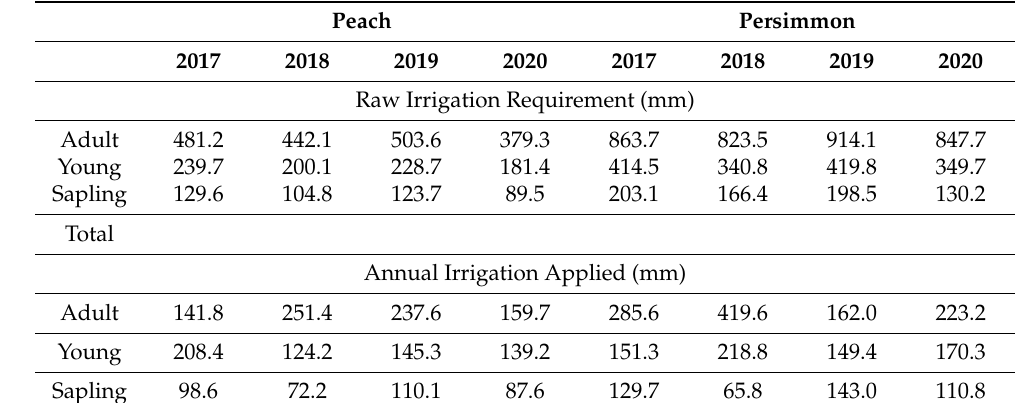
Table 5. Calculated raw irrigation requirements and averages of the annual irrigation depths applied to the different plots for persimmon and peach orchards for years 2017, 2018, 2019, and 2020.